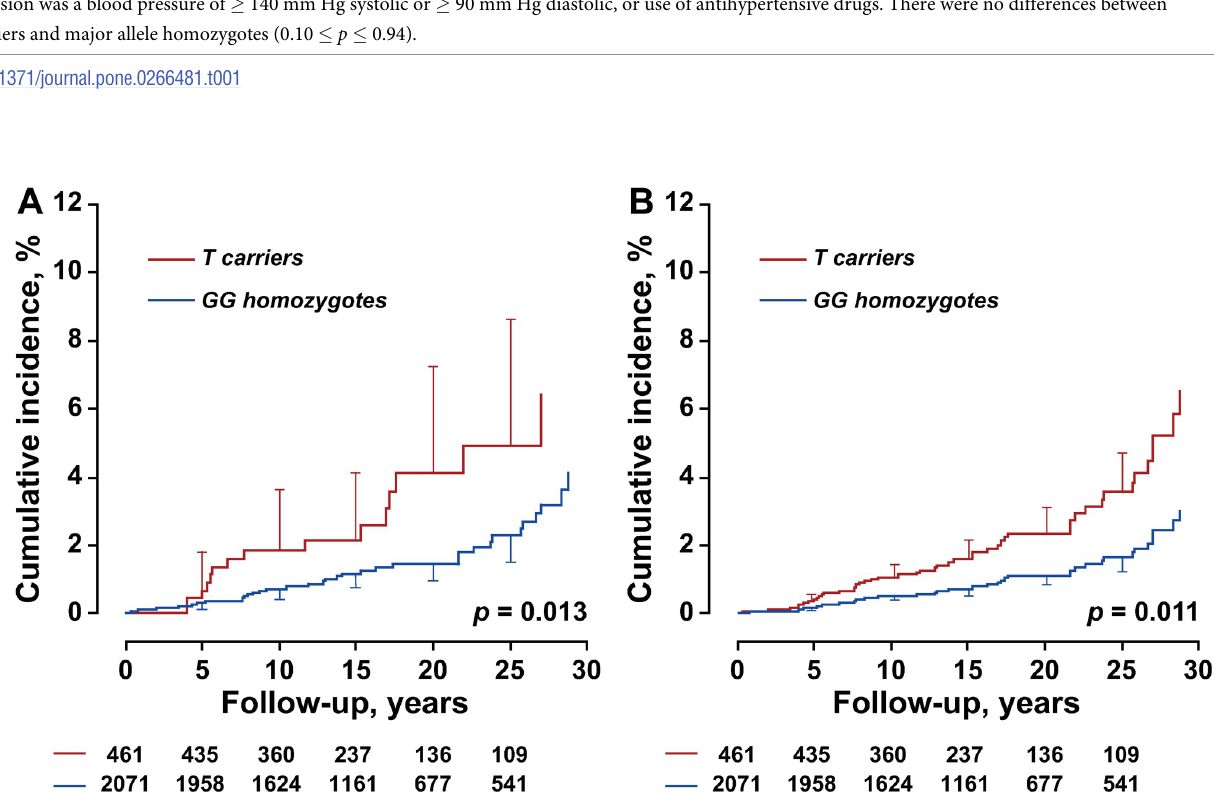
Fig 2. Unadjusted (A) and sex- and age-adjusted (B) cumulative incidence of colorectal cancer by rs12566888 genotype. Vertical bars denote the standard error. Median follow-up was 18.1 years. P values are for the between-genotype differences. Tabulated data are the number of participants at risk by genotype at 5-year